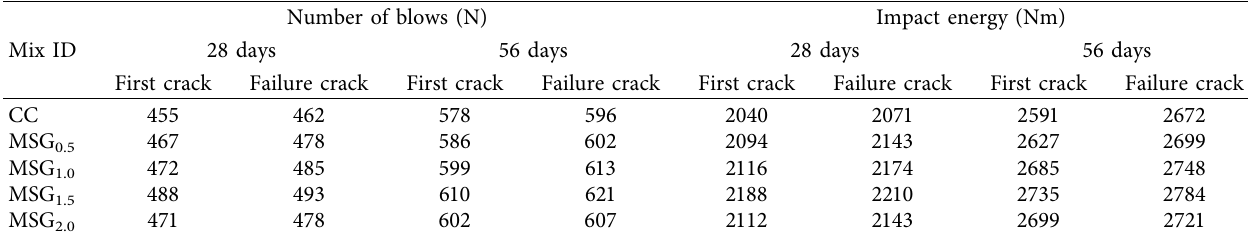
Table 4: Impact energy of various mixes.